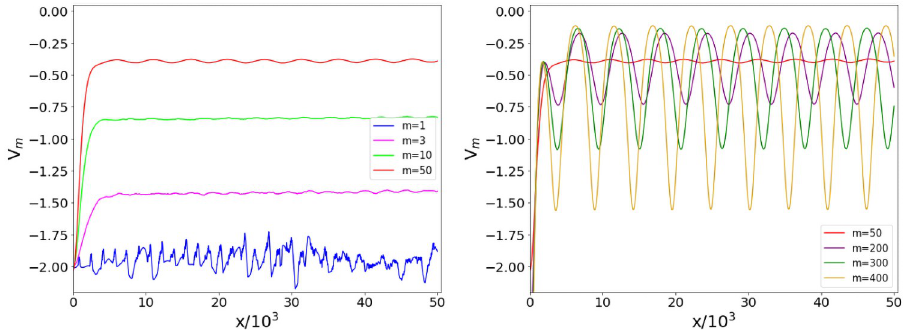
computed over 100 BA networks with m